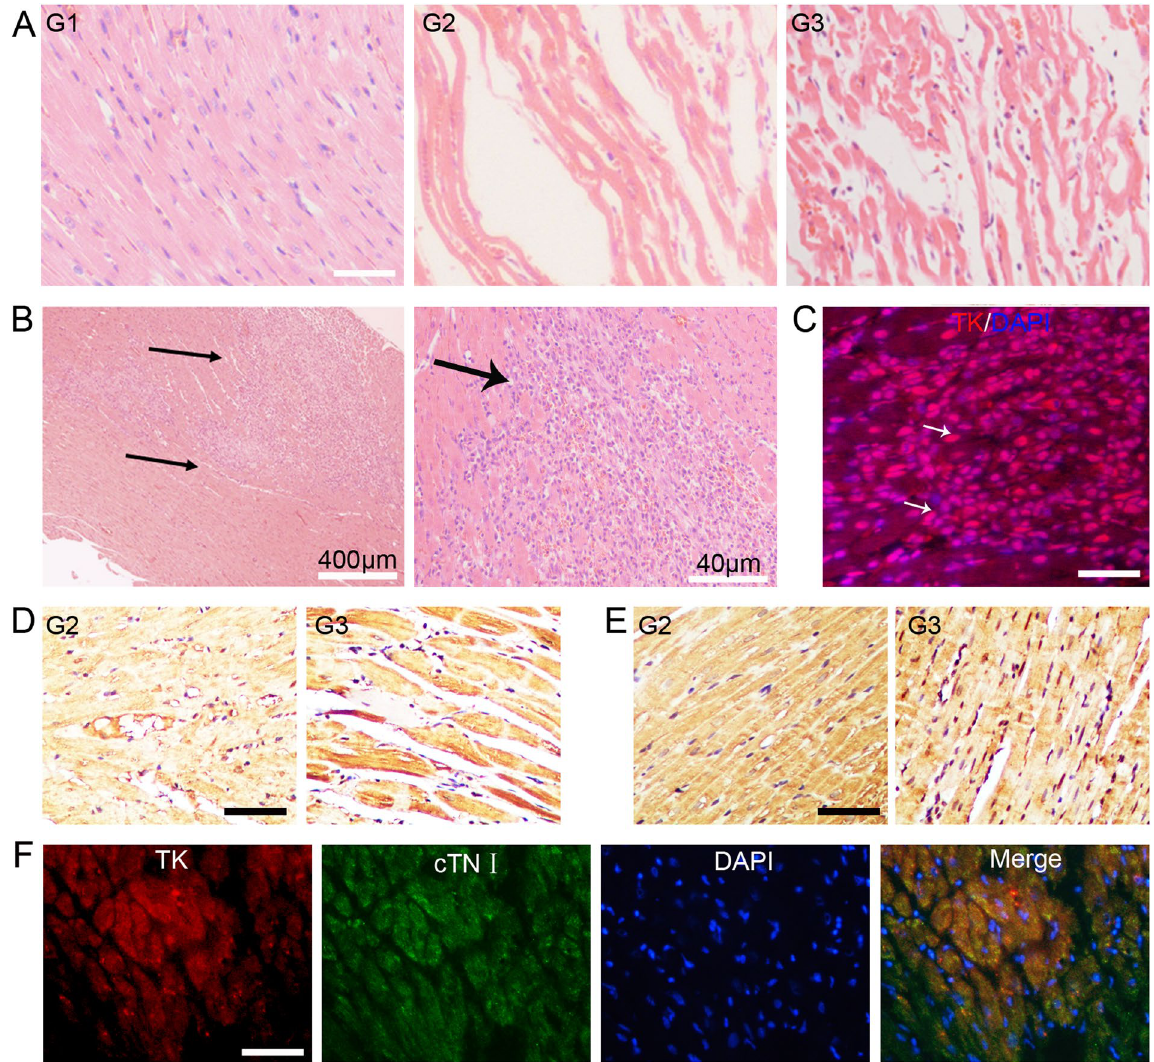
Figure 5. Characterisation of the MI model and ex vivo analysis of rat myocardial tissue 45 days after MI. ( A ) Haematoxylin and eosin staining of myocardium from the sham-operated (G1), MI model (G2), and transfected-BMSC-treated MI model (G3). Scale bar, 50 μ m. ( B ) Haematoxylin and eosin staining of heart tissue sections from the G3 group. Arrows indicate BMSCs. ( C ) HSV1-tk (red) and DAPI (blue) immunohistochemical staining of rat heart tissue from the G3 4 days after treatment. Arrows indicate overlapping (i.e. positive) staining of transplanted labelled BMSCs. Scale bar, 30 μ m. ( D ) Immunostaining for GATA-4 and cardiac troponin I (cTnI) ( E ) in myocardium derived from α -MHC-induced differentiation of BMSCs. Scale bar, 50 μ m. ( F ) Immunocytochemical analysis of HSV1-tk (red) and the cardiomyocyte-specific marker cTnI (green), and DAPI staining (blue), and their colocalisation in heart tissue from the G3 45 days after transplantation. Scale bar, 50 μ